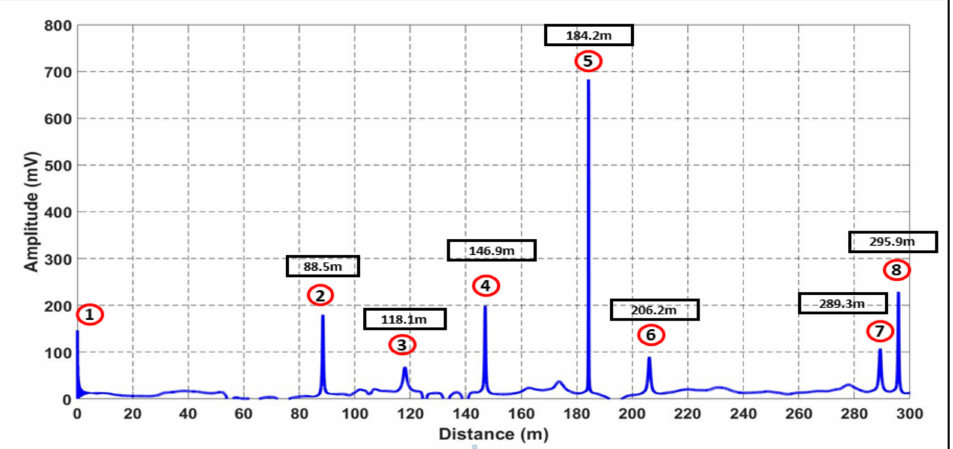
Figure 20. Hilbert Transform (HT) analysis IMF series 4 for no-leak induced.